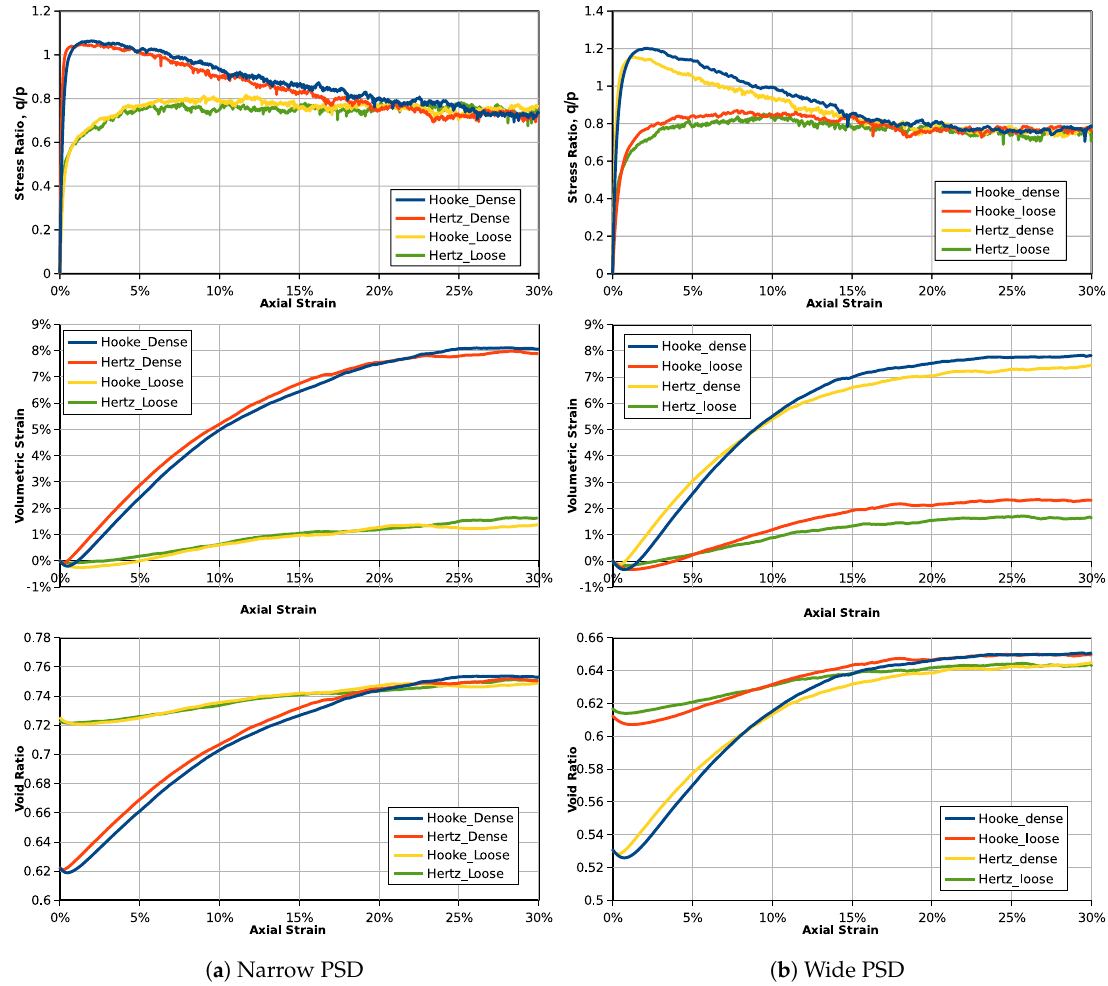
Figure 4. Stress-strain behaviors for samples sheared from the same dimensionless